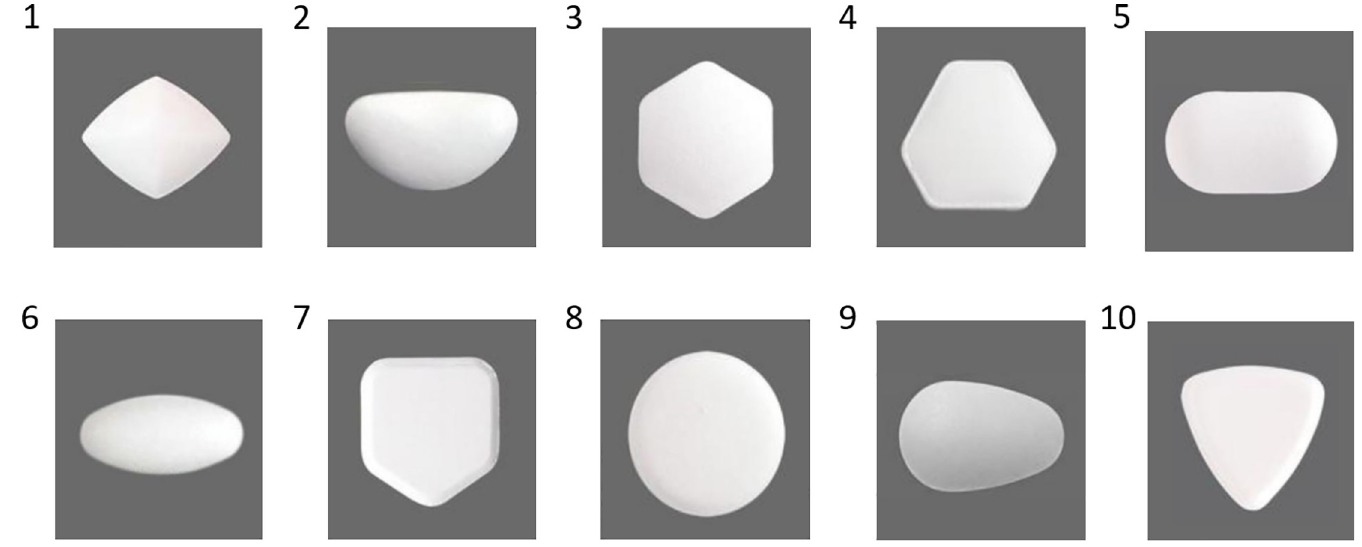
Fig 8. Angular vs. curved photograph pill stimuli used in Study